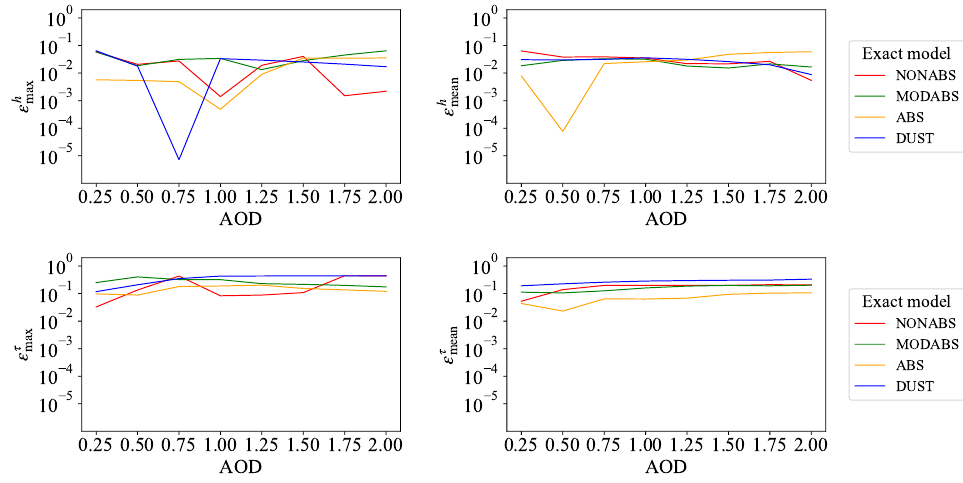
Figure 5. Relative errors ε τ , h mean,max ( τ e , h e = 3.5 km ) for the aerosol models from Set 2.